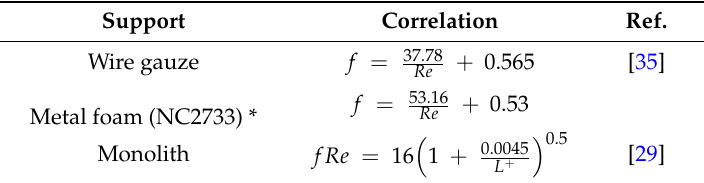
Table 4. Flow resistance